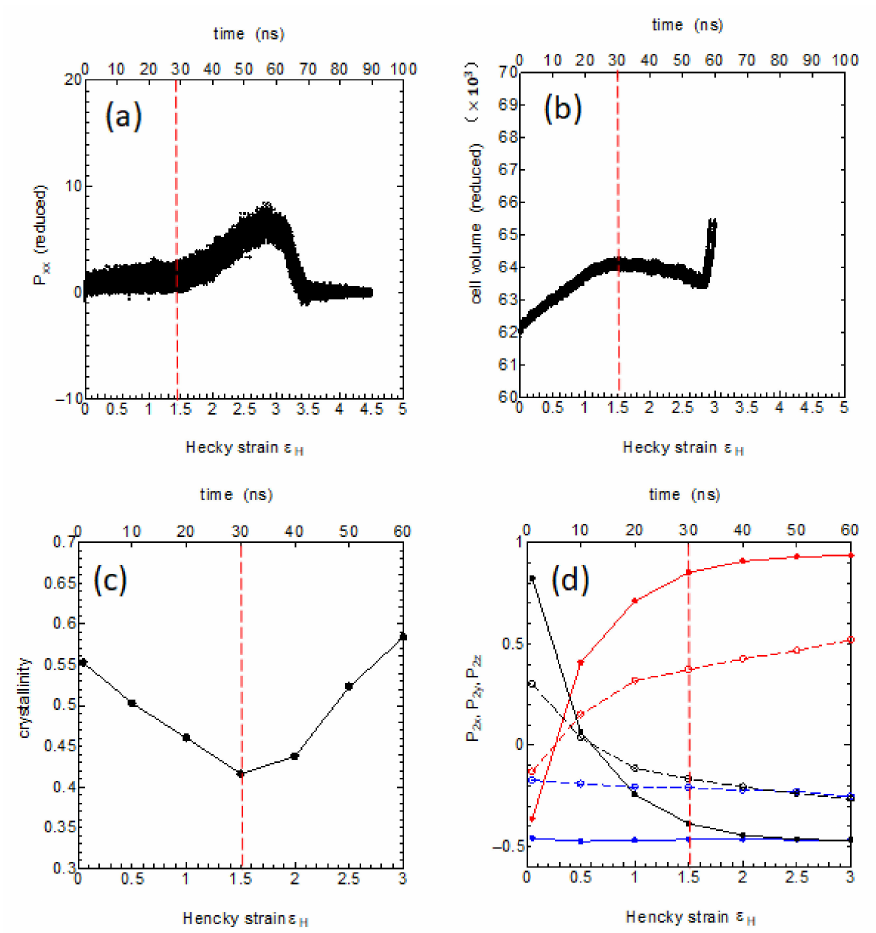
Figure 11. Analyses of the structural changes during the large T-type deformation of Figure 10 using various order parameters vs. ε x , ( a ) the stress–strain relation between the stress P xx and the Hencky-strain ε x , ( b ) the MD cell volume, ( c ) the crystallinity x mesh c , and ( d ) in the orientational order parameters P 2 x , P 2 y , P 2 z along the x-, y-, z-axes, in red, blue, and black, respectively; the filled circles with solid lines are those for the crystalline domains while the open circles with dashed lines are those for the amorphous